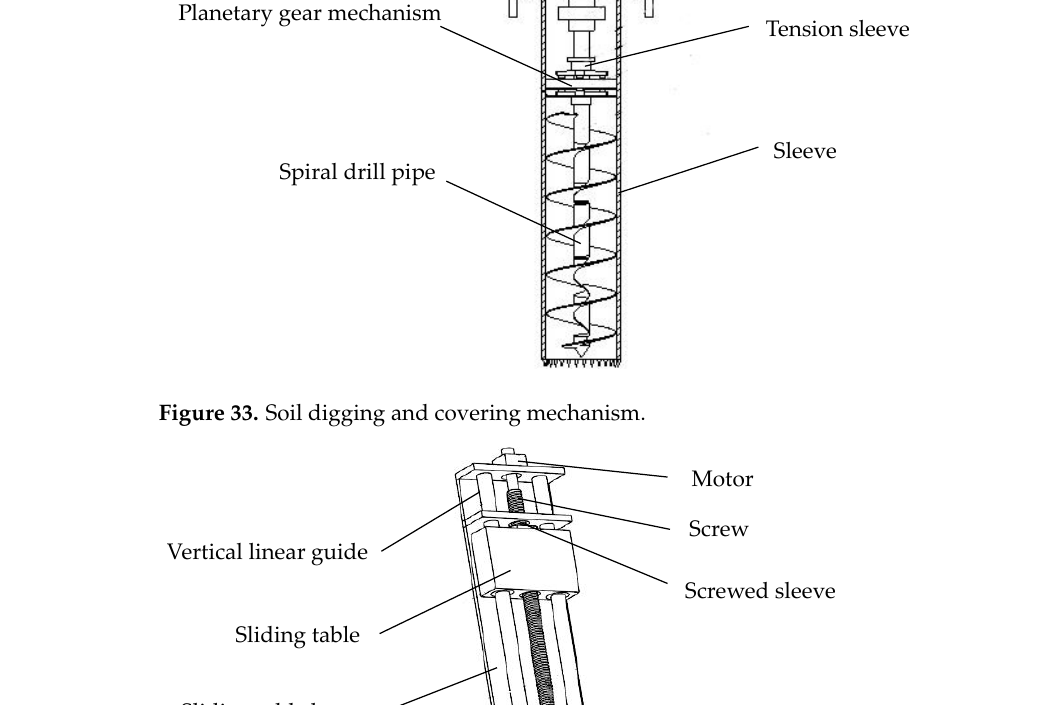
Figure 34. Linear guide mechanism.